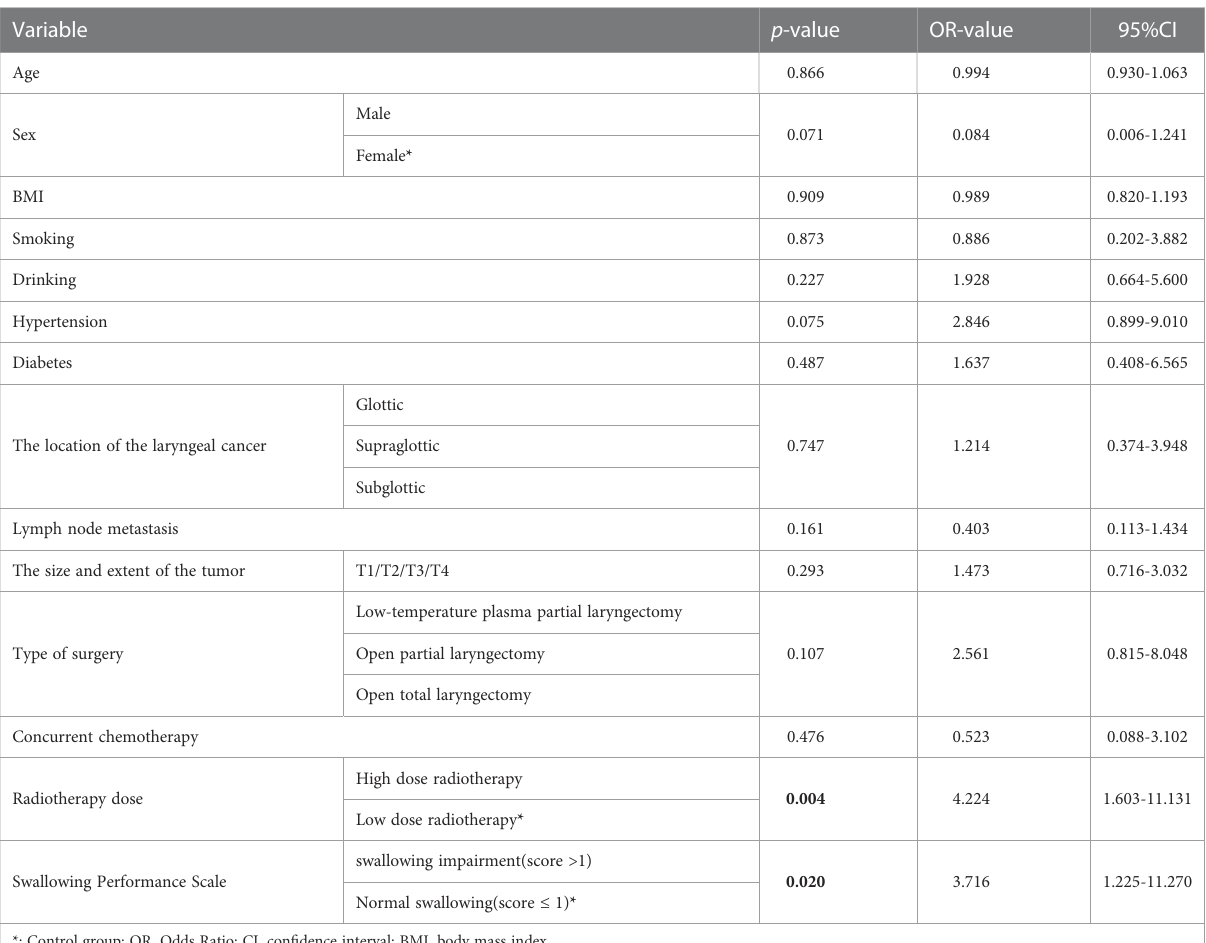
TABLE 5 Results of binary logistic regression for